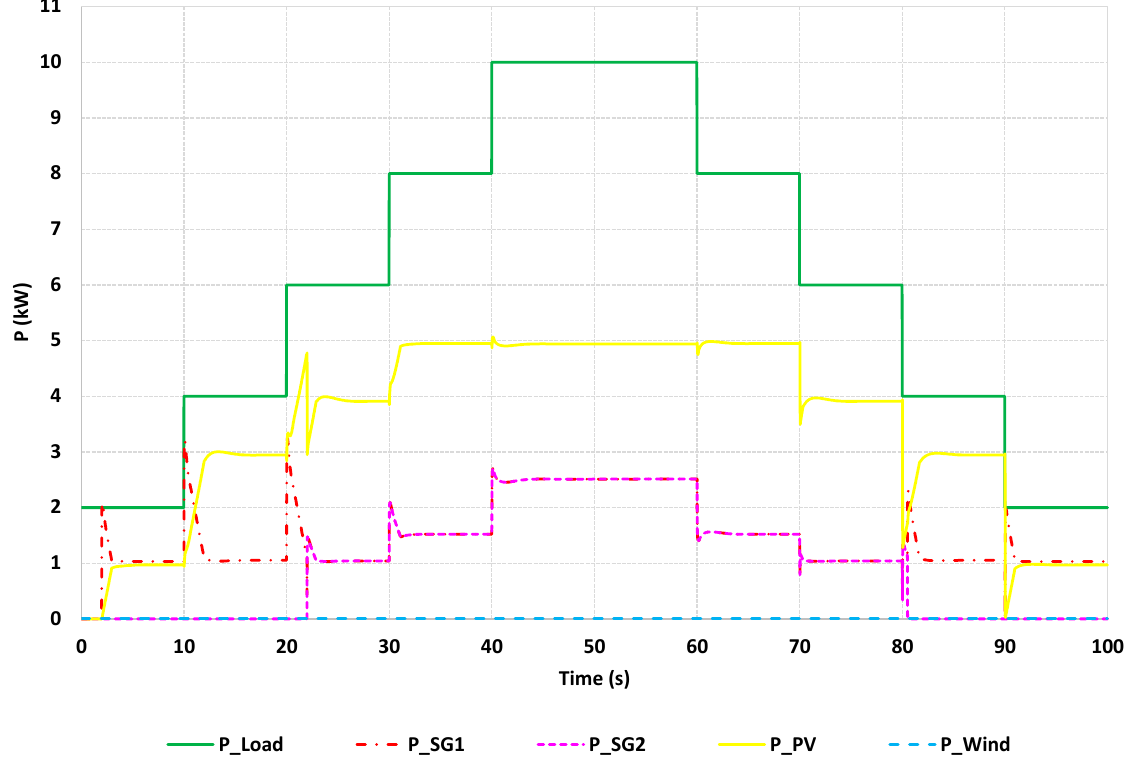
Figure 5. Scenario 2: Variable demand curve, maximum solar PV generation and zero wind generation.